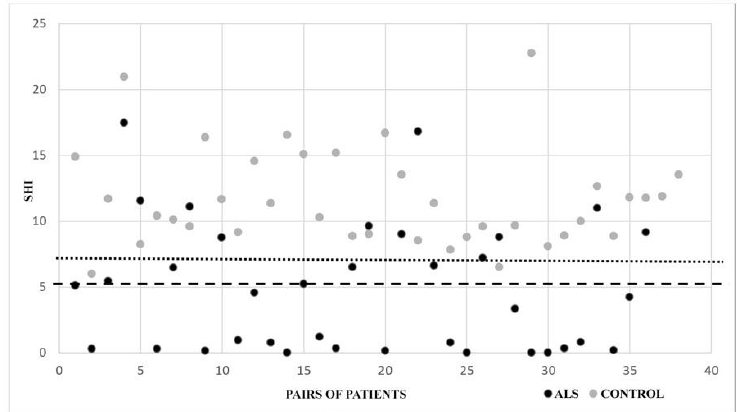
Figure 2. ROC curve evaluating SHI values for the diagnosis of ALS.